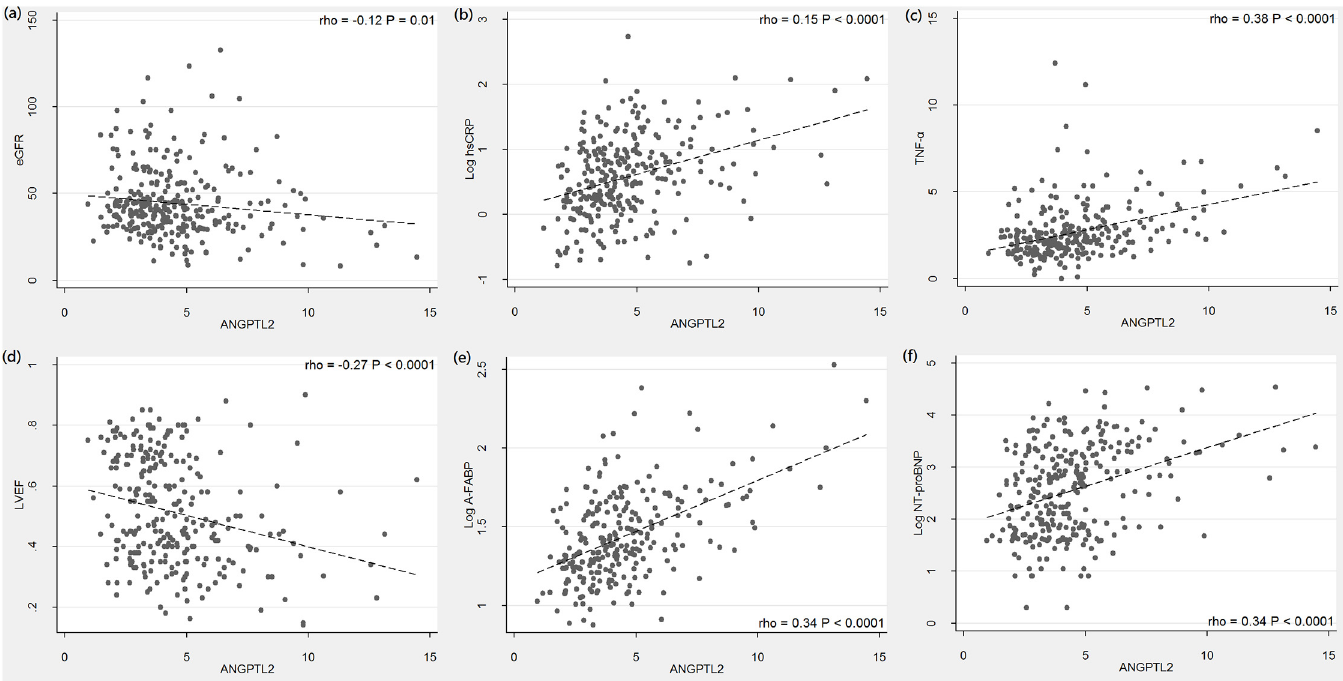
Fig 1. Scatter plot showing the relationship between serum ANGPTL2 levels and other clinical parameters. ANGPTL2 levels were positively correlated with hsCRP, TNF- α , A-FABP, NT-proBNP, and negatively correlated with eGFR and LVEF. (The Spearman correlation coefficients rho are presented).